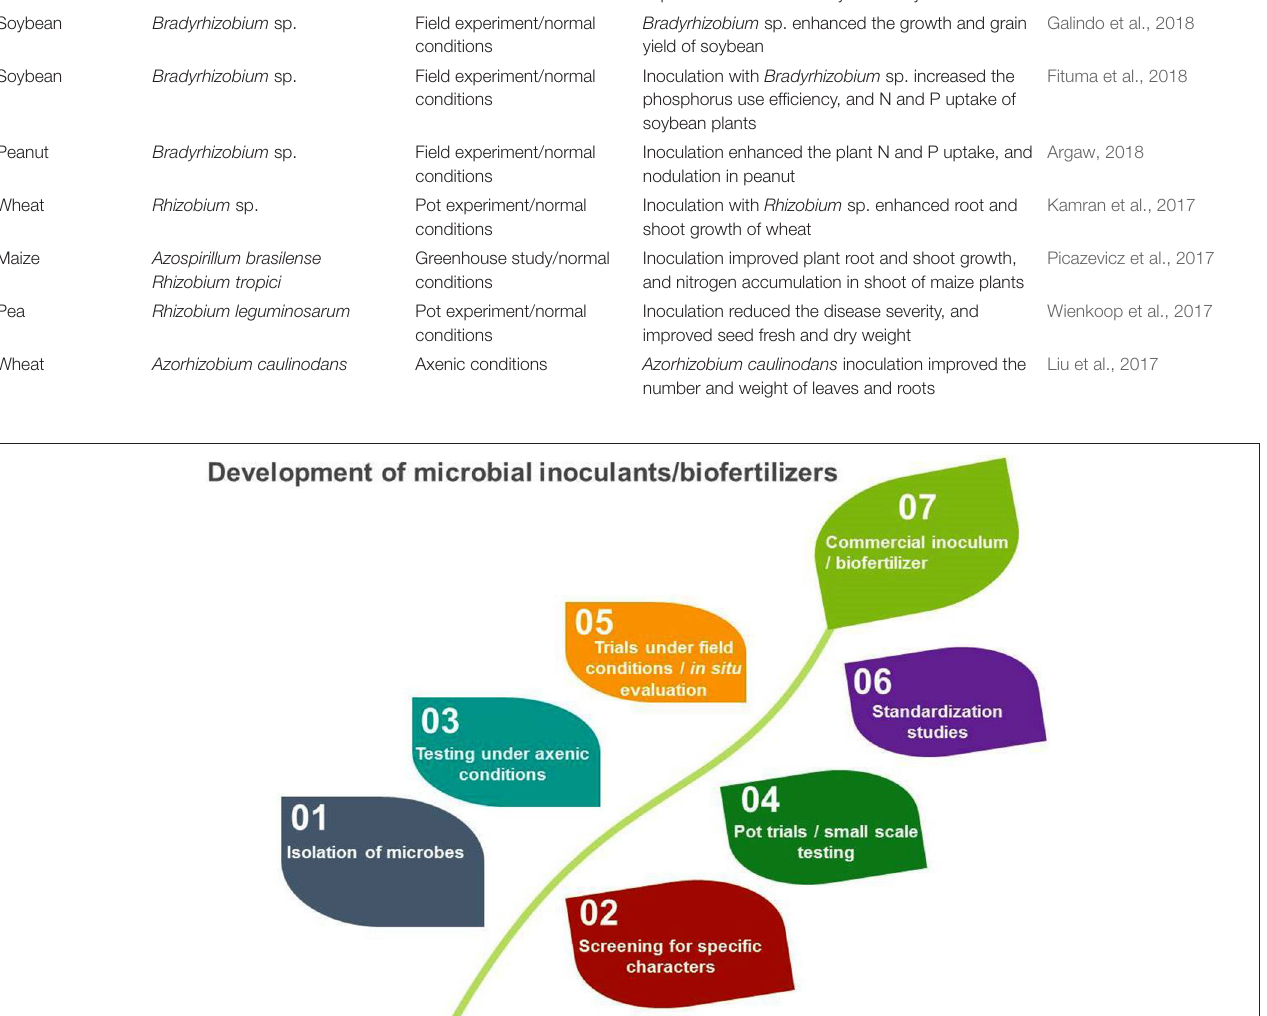
prevent plant diseases indicates their potential as effective biopesticides. Studies have shown beneficial microbes in soil destroy pathogens, such as fungal, bacterial and viral diseases, insects, weeds, and nematode pests, through biocontrol or ISR (Gao et al., 2015). Many researchers focused on effects of microorganisms on seed germination and young weed seedlings ( Harding and Raizada,